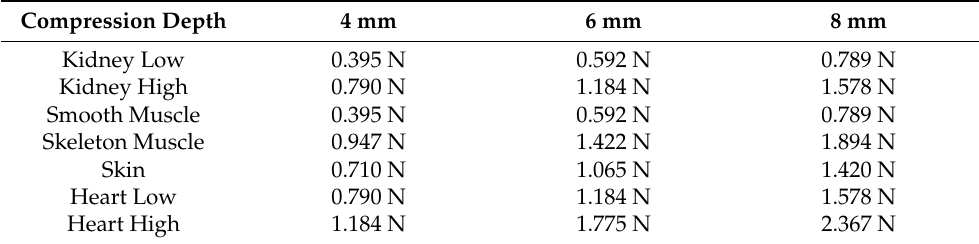
Table 2. Maximum repulsive force using the finite element method